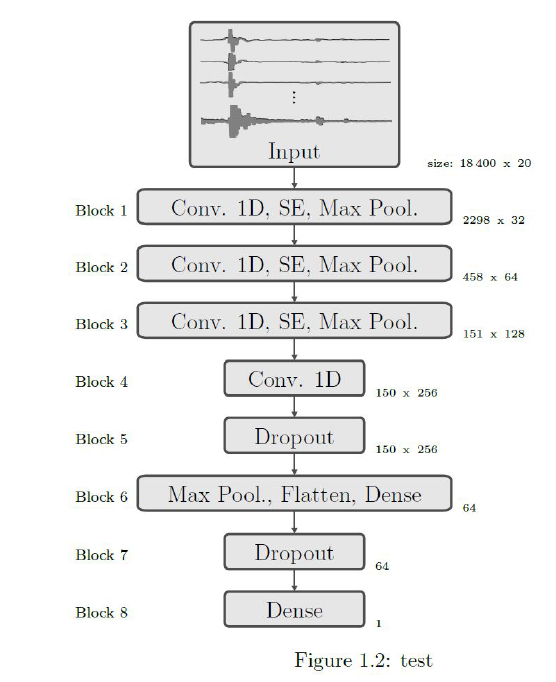
Figure 3. The neural network architecture used for the experiments in this paper. Blocks 1 to 3 consist of a convolution layer with additional layers such as squeeze and excitation layer and max pooling